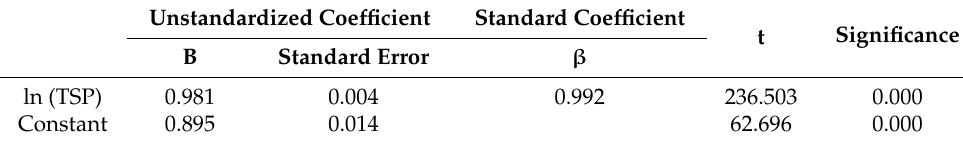
Table 6. Table 6. Coefficients.